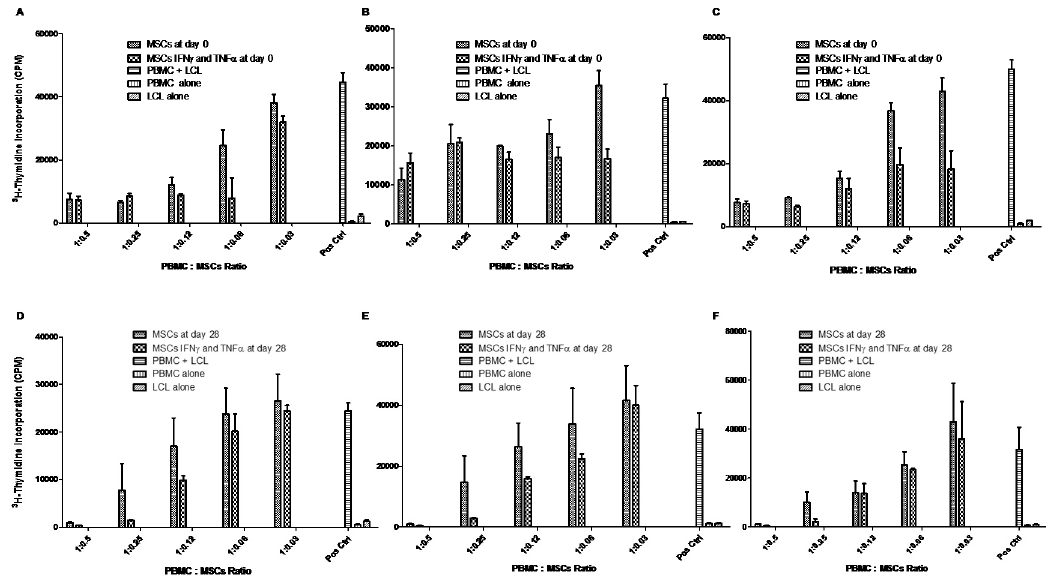
Figure 8. WJ-MSCs (Day 0) and chondro-MSCs (Day 28) showed immunomodulatory properties in a dose dependent manner. Distinct WJ-MSCs ( A – C ) and chondro-MSCs ( D – F ) primed with pro-inflammatory cytokines, or not, were added as third-party cells at various ratios into an MLR using PBMC as HLA-mismatched responder T cells towards irradiated LCL used as stimulating cells. Control without MSCs correspond to PBMC + LCL (Pos Ctrl). Data are expressed as mean CPM ± SD.